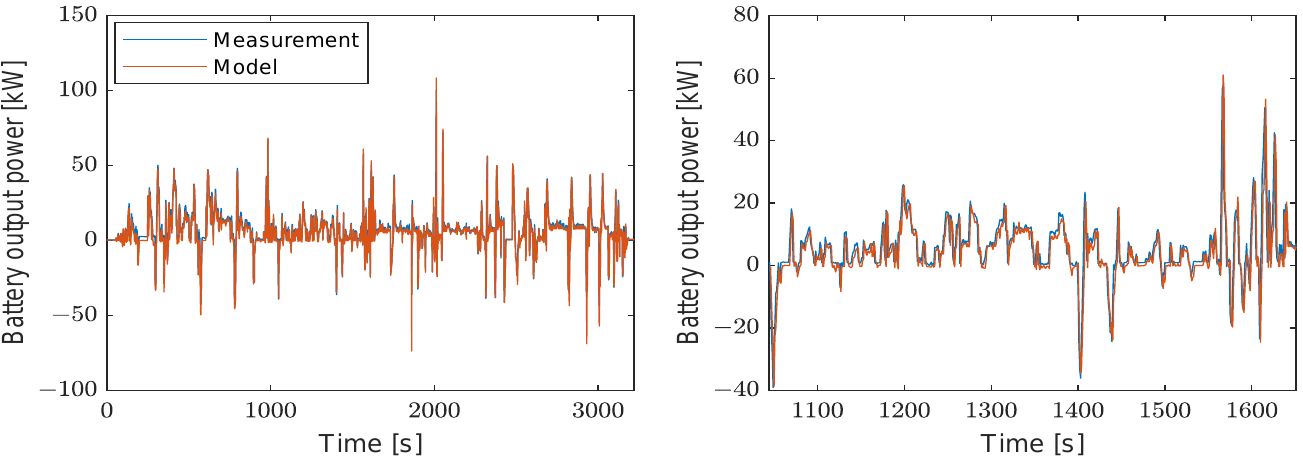
Figure A6. Validation of the battery output power for the